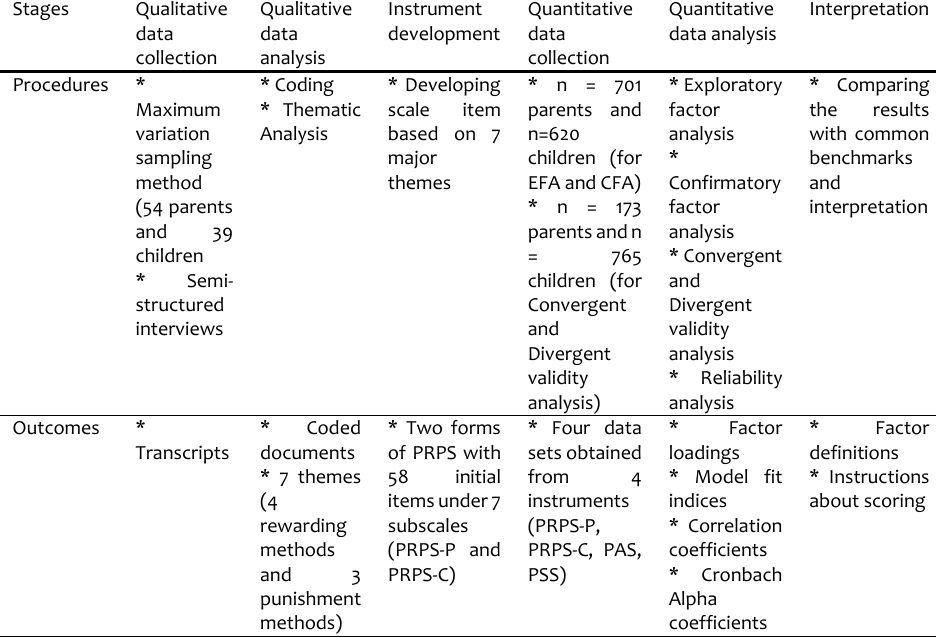
Table 1. Exploratory mixed methods research